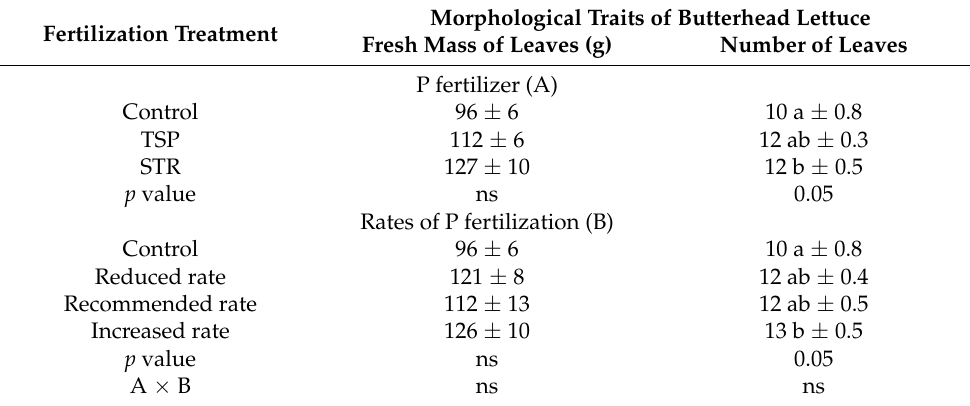
Table 2. Effect of various rates of P from STR and TSP fertilizers on selected plant traits. Morphological Traits of Butterhead Lettuce Fertilization Treatment Fresh Mass of Leaves